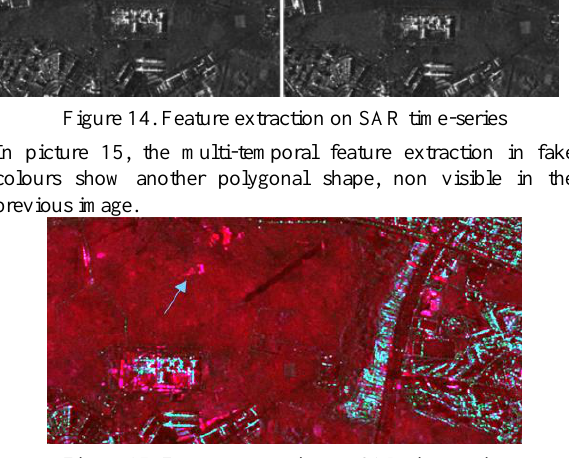
Figure 15. Feature extraction on SAR time-series